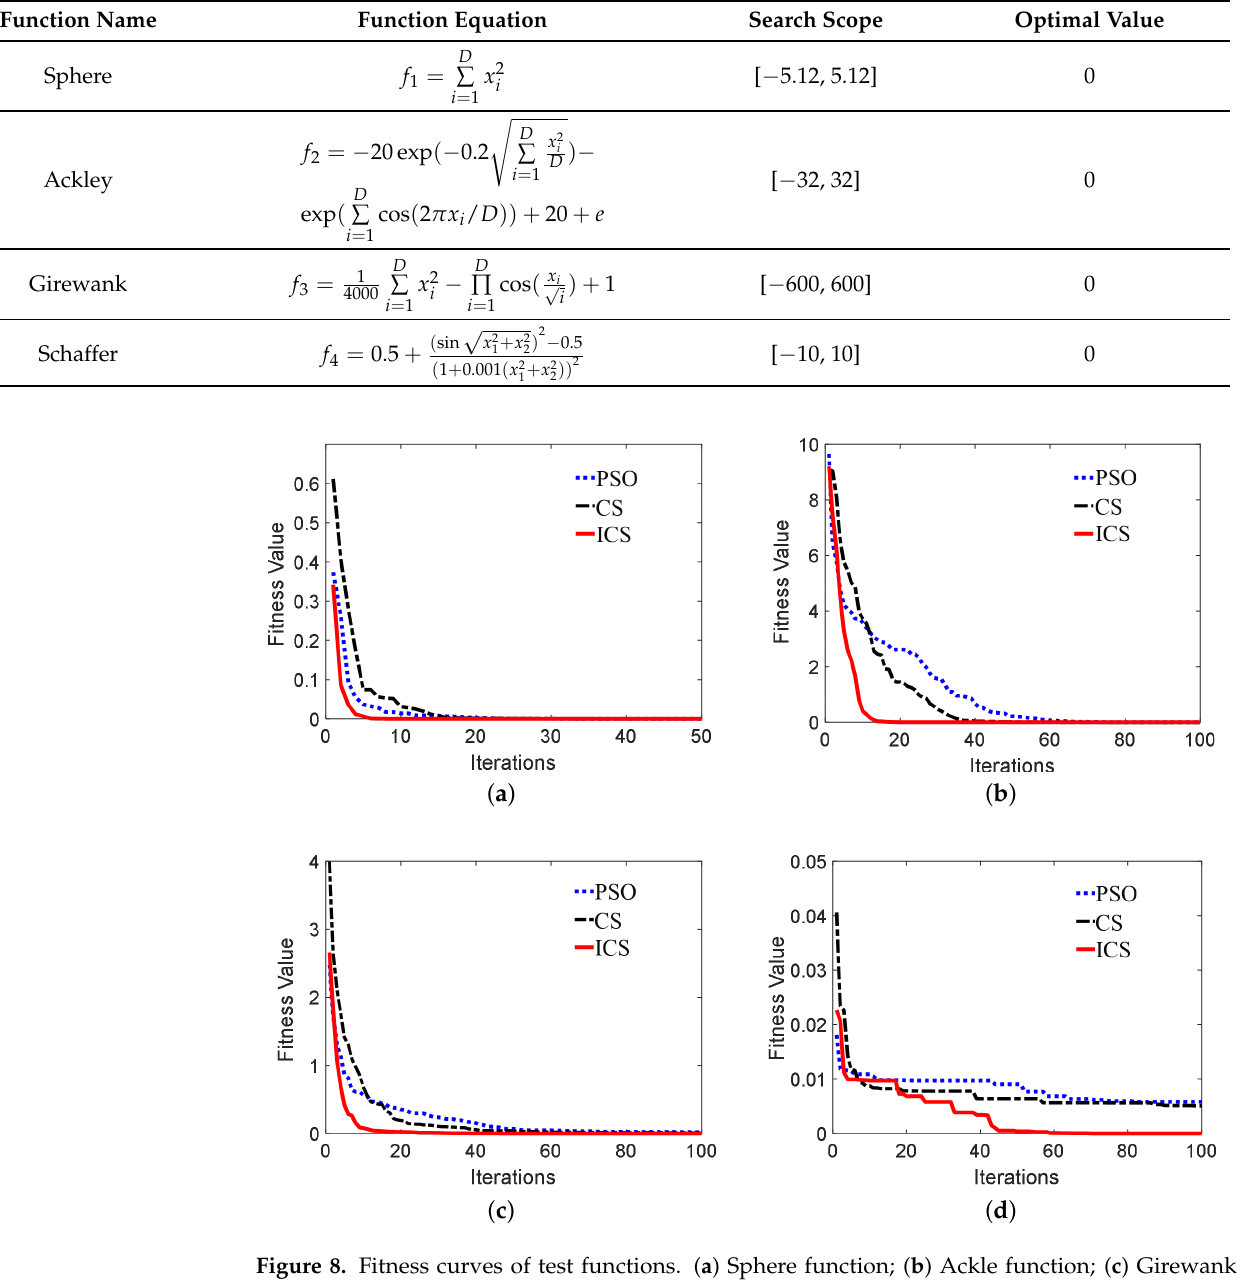
Table 1. Test functions.